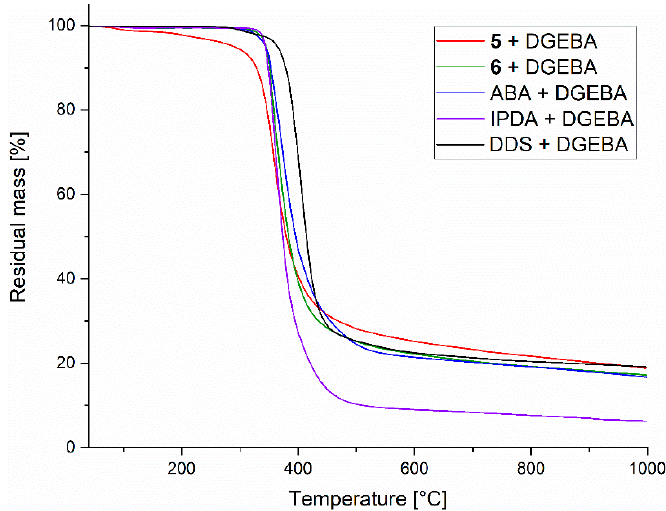
Figure 5. TGA curves of the investigated amines combined with DGEBA.